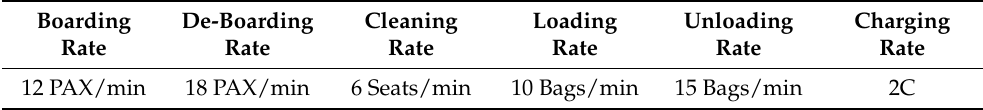
Table 9. Turnaround calculation basis for the passengers, baggage and